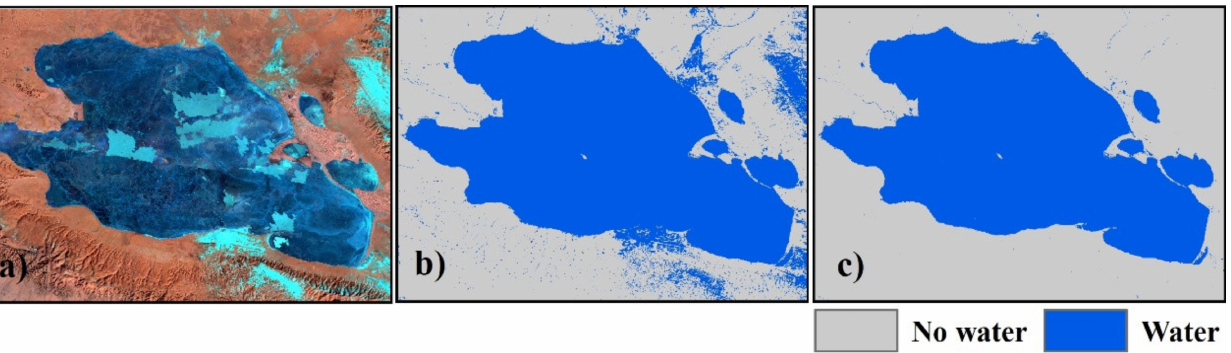
Figure 5. Illustration of the effect of the max-extent masking. ( a ) is the original image of Qinghai Lake in January 1990, in which the lake is frozen, and the light blue part is the snow-covered area; ( b ) is the preliminary extraction result; ( c ) is the result after max-extent